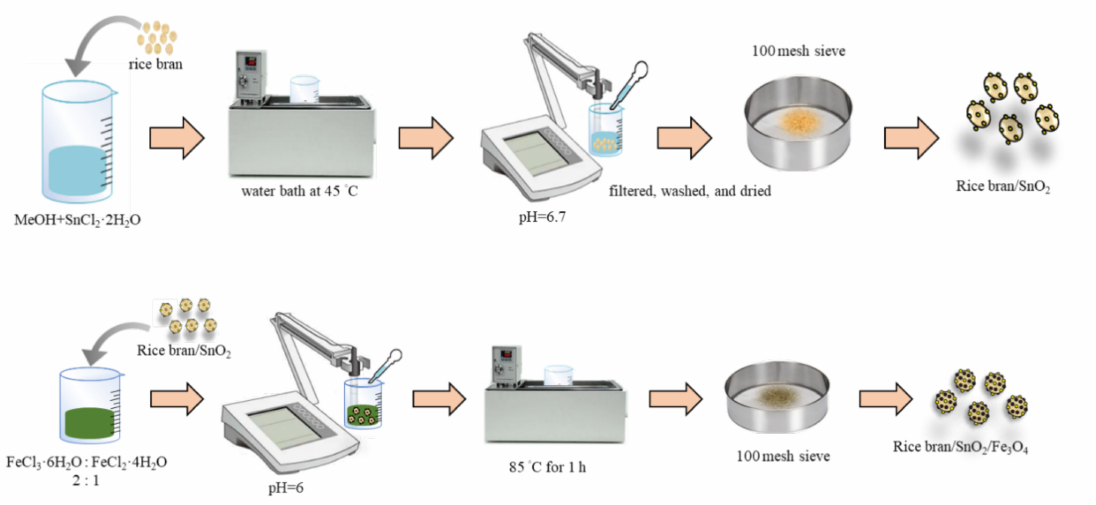
Figure 1. Preparation schematic diagram of rice bran / SnO 2 / Fe 3 O 4